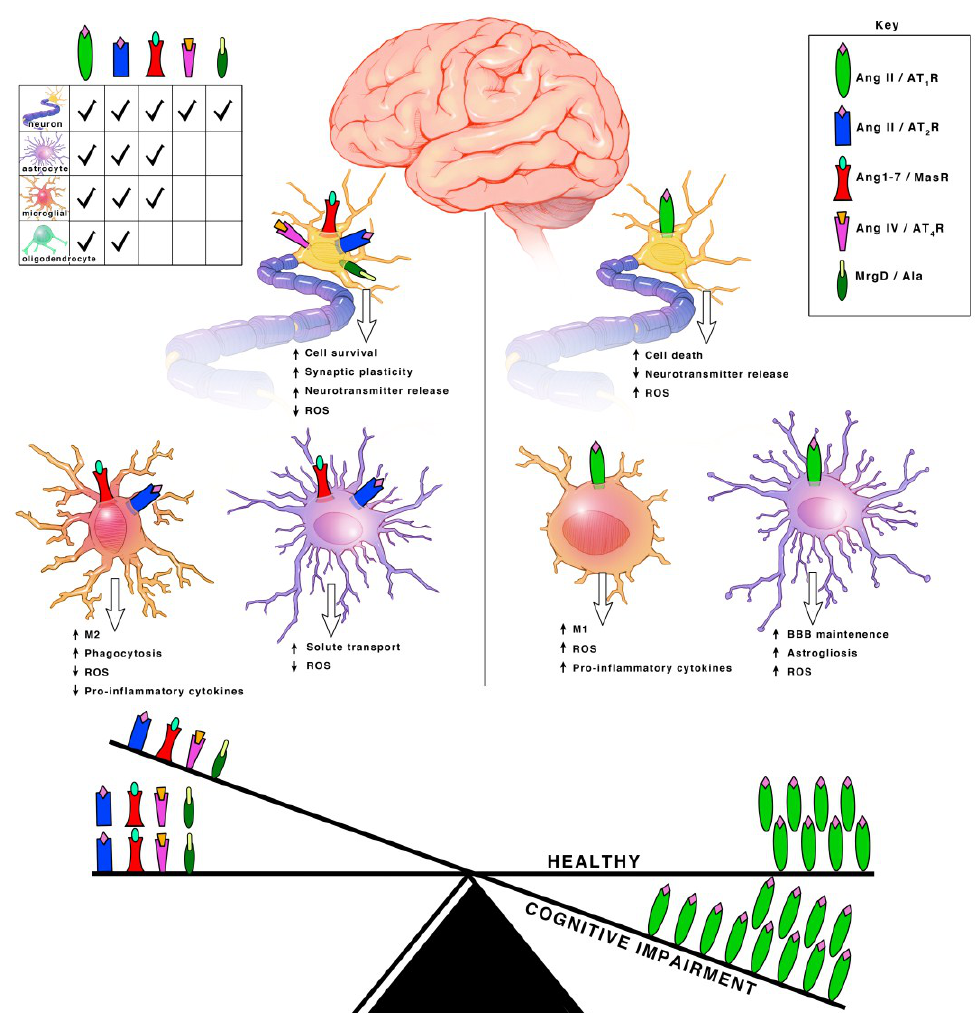
Figure 3. Schematic Representation of The Biological Actions of The RAS System In The Brain.